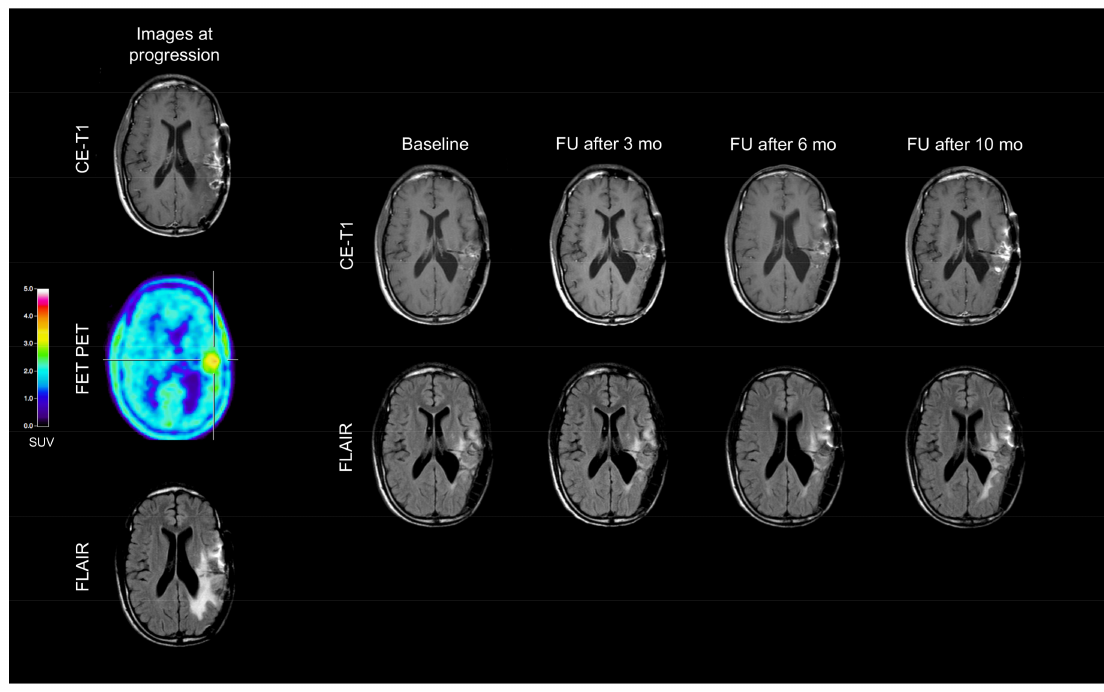
Figure 2. In December 2014, Magnetic Resonance Imaging (MRI; left column) shows a contrast-enhancing lesion and an enlarged FLAIR hyperintensity in the left temporoparietal lobe. The corresponding Positron-Emission-Tomography (PET) scan using O -(2- 18 F-fluoroethyl)- L -tyrosine (FET) depicts increased metabolic activity in spatial correlation with the contrast enhancement. MR and PET images are consistent with tumor progression. Compared to baseline MRI, follow-up (FU) MRI findings (right rows) during dabrafenib therapy remain unchanged until the tumor progression ten months after dabrafenib